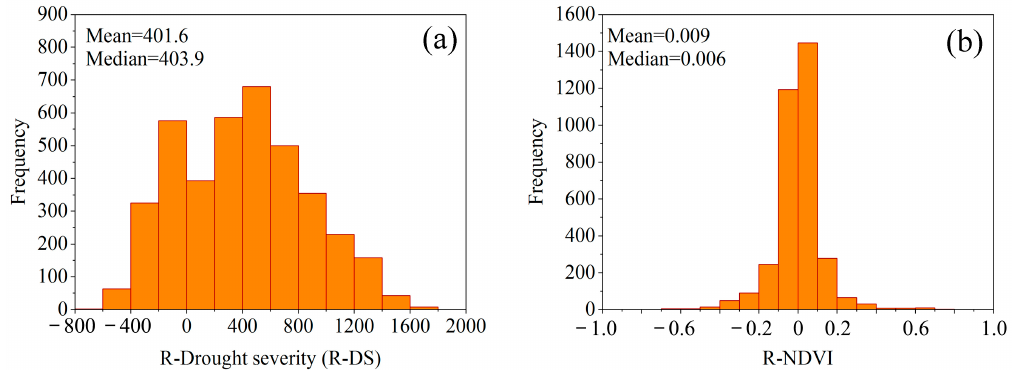
Figure 8. The frequency distribution of the R-DS ( a ) and the R-NDVI indices ( b